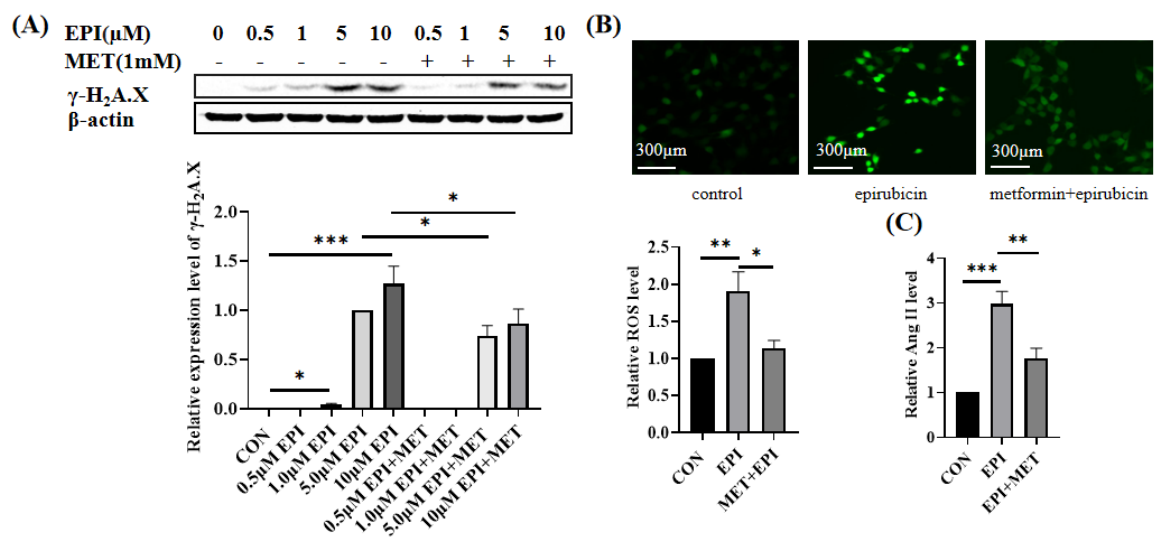
Figure 1. Metformin alleviates epirubicininduced HUVEC cell dysfunction. ( A ) Expression levels of γ − H2A.X. HUVEC cells were respectively incubated with 0.5 µ M, 1 µ M, 5 µ M or 10 µ M EPI for 12 h with or without the pretreatment of 1 mM metformin for 12 h. The 5 µ M epirubicin treatment group was used as the reference. ( B ) Levels of ROS. HUVEC cells were treated with 5 µ M epirubicin for 6 h with or without the pretreatment of 1 mM metformin for 12 h. ROS levels were then detected by 5 mM DCFH − DA probe. ( C ) Levels of Ang II in the supernatant. HUVEC cells were h. Then, the levels of Ang II in the supernatant were detected by ELISA. EPI — epirubicin, MET —